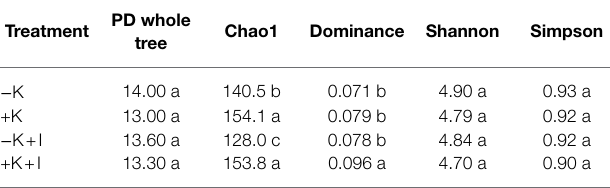
TABLE 3 | Alpha diversity of bacterial community in flag leaf sheath after Sarocladium oryzae inoculation. PD whole Treatment tree